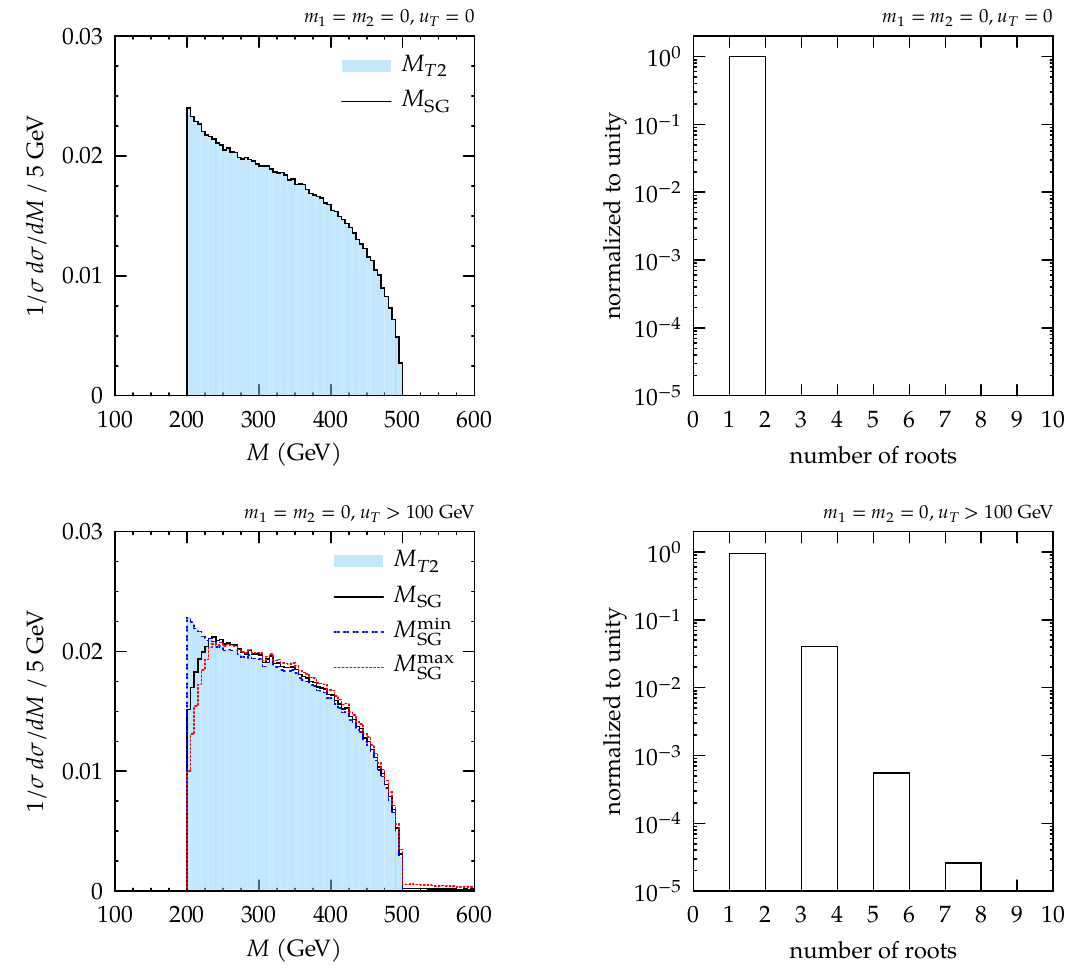
Figure 2 . Distributions of the singularity variables M SG and M T 2 (left) and the number of roots of reduced rank conditions (right) for phase-space events of M Y = 500 GeV and M χ = 200 GeV. In the upper panels, the upstream momentum u T is vanishing, while in the lower panels, it is larger than 100 GeV. The visible particle systems are all massless, m 1 = m 2 = 0 , and we have taken M χ = M true